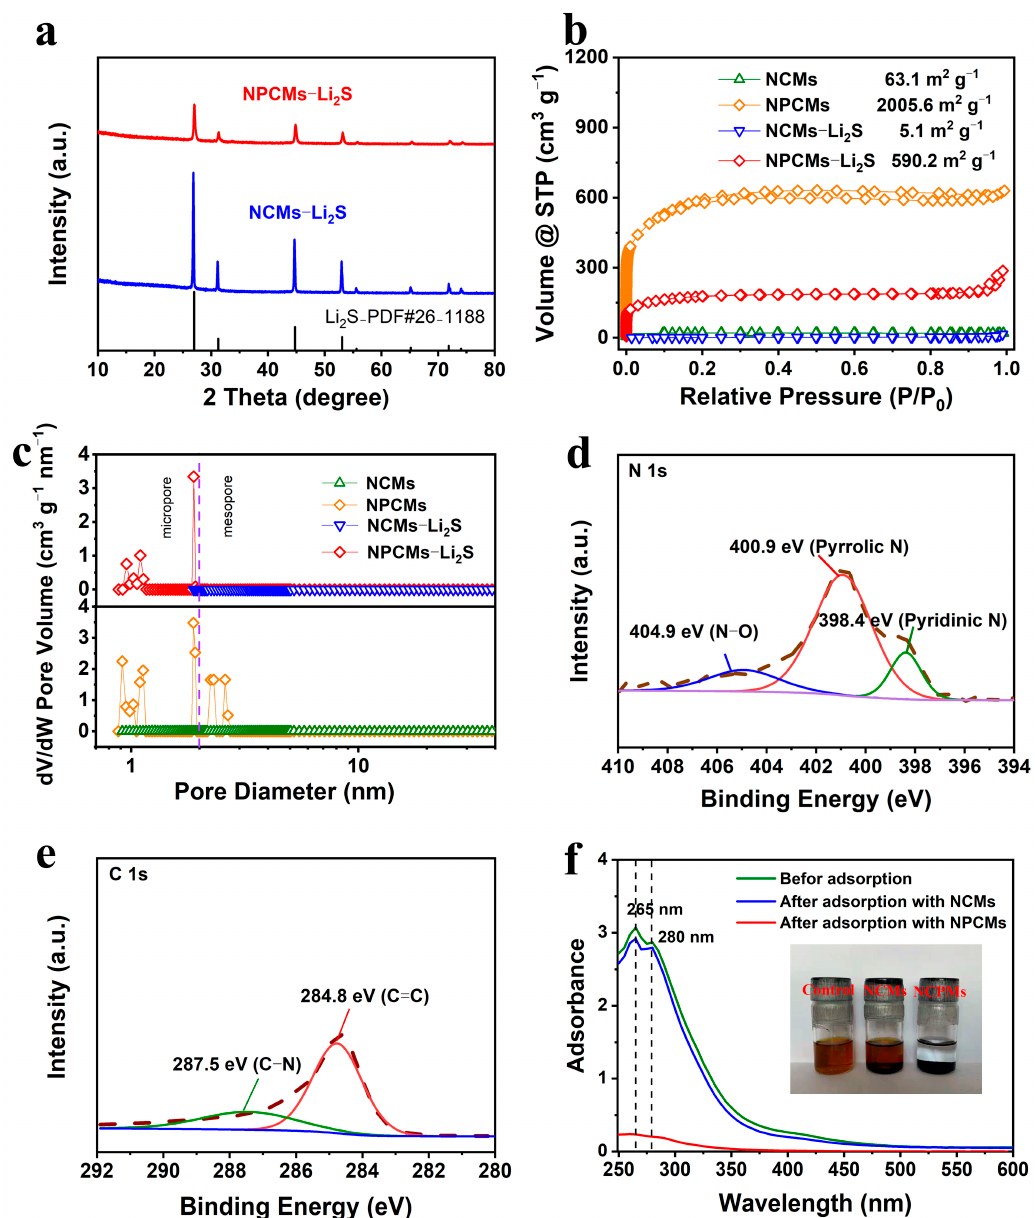
Figure 2. ( a ) XRD patterns of NCMs–Li 2 S and NPCMs–Li 2 S composites; ( b ) N 2 adsorption–desorption isotherms and ( c ) corresponding pore size distributions of NCMs, NPCMs NCMs–Li 2 S and NPCMs–Li 2 S; XPS spectra of NPCMs ( d ) N 1s spectrum and ( e ) C 1s spectrum; ( f ) UV-VIS absorption spectra of NCMs and NPCMs in Li 2 S 6 solution.